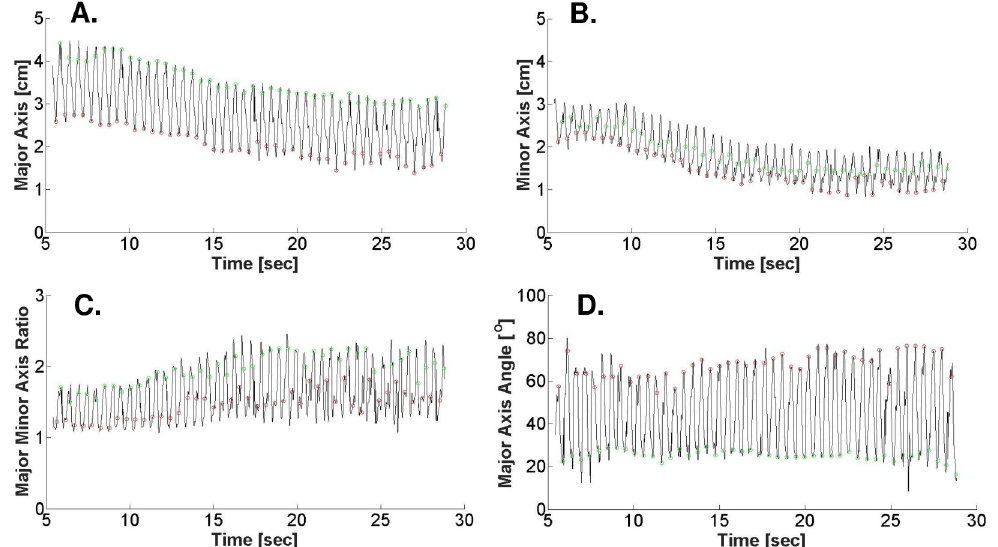
Fig 5. Changes in LV geometry before and during VCO. Shape changes were quantified by 4 indicators calculated from the fitted ellipse: (A) Major Axis length, (B) Minor Axis length, (C) Major to Minor Axis Ratio, and (D) Major Axis Orientation Angle. Green makers = end-diastole (ED), Red markers = end-systole (ES).